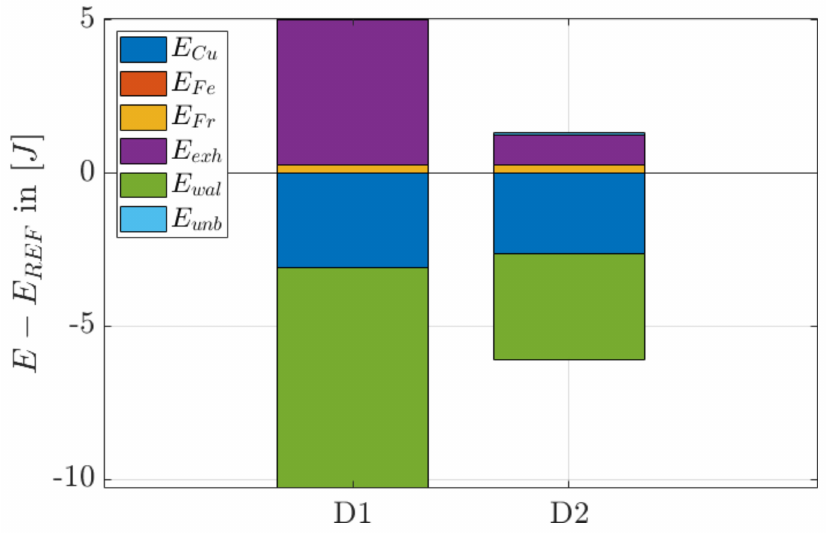
Figure 34. Energy losses for trajectory D1 and D2 with respect to